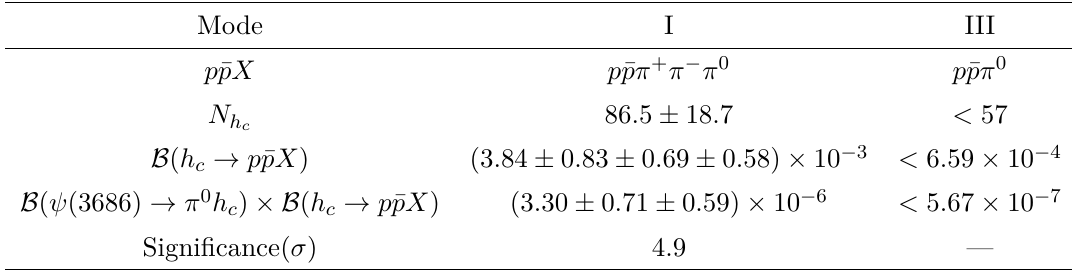
Table 2 . The number of observed signal events N h the product branching fraction B ( ψ (3686) → π 0 h including systematic uncertainties. Here, the first uncertainty is statistical, the second is systematic, and the third one arises from the branching fraction of ψ (3686) → π 0 h